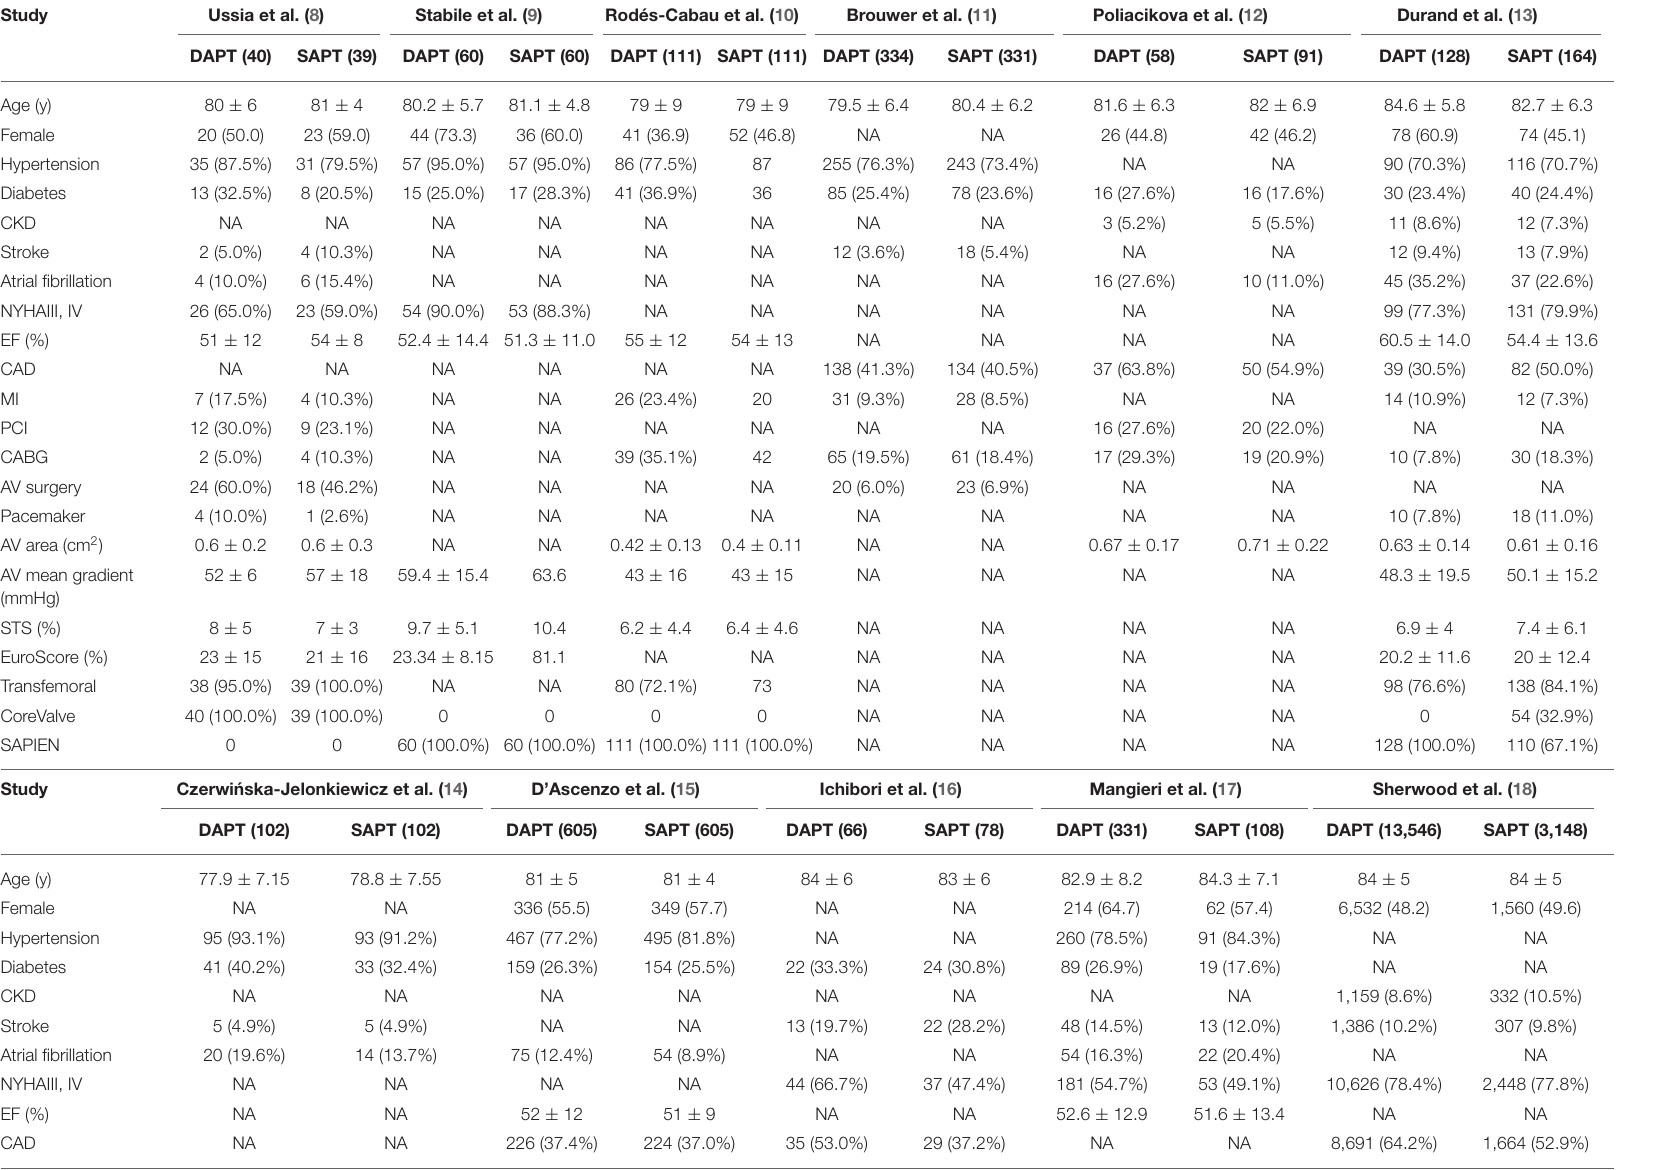
TABLE 2 | Baseline characteristics of the included patients and